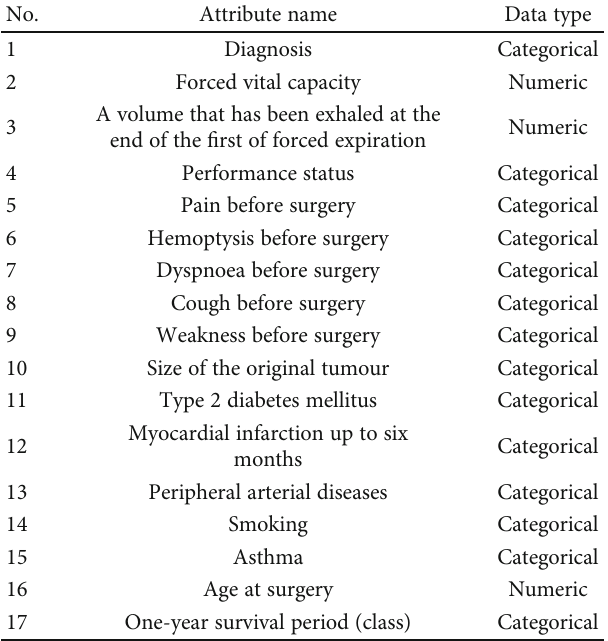
Table 3: The features of THS dataset.